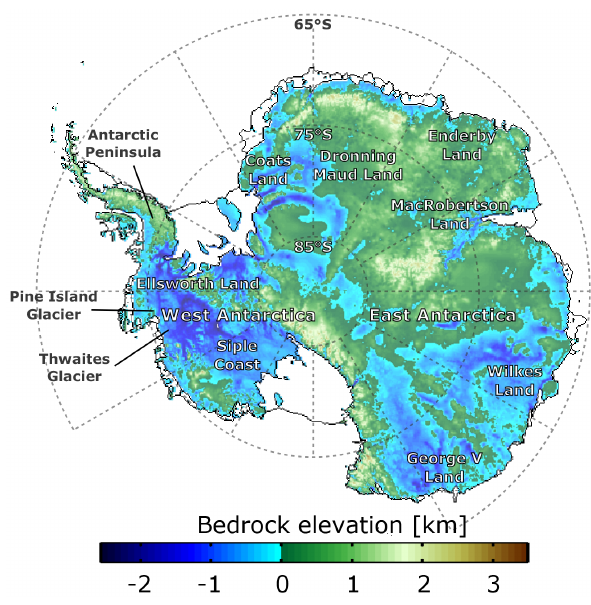
Figure 1. A bedrock elevation map of Antarctica obtained from the BEDMAP2 data set (Fretwell et al., 2013), including the location of the sites mentioned in the